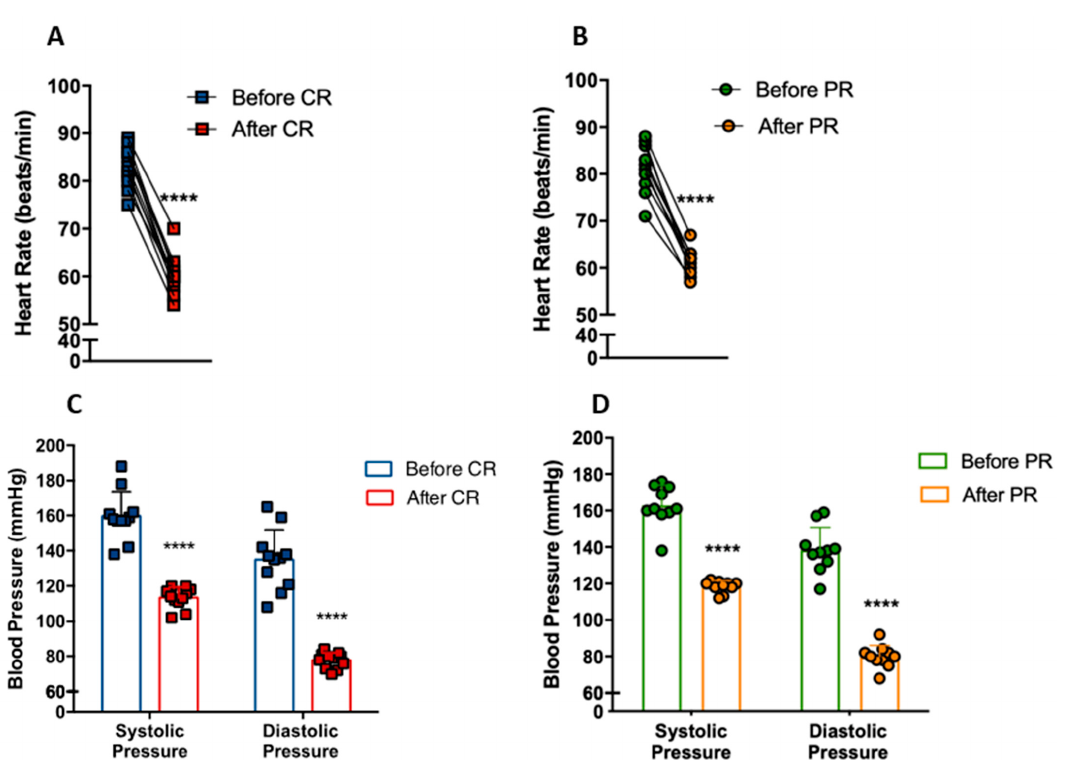
Figure 3. Reduction of cardiovascular disease risk factors after caloric restriction (CR) or protein restriction (PR). ( A ) Heart rate at rest before and after caloric restriction (**** p = < 0.0001). ( B ) Heart rate at rest before and after protein restriction (**** p = < 0.0001). ( C ) Blood pressure before and after caloric restriction (**** p = < 0.0001). ( D ) Blood pressure before and after protein restriction (**** p = < 0.0001). Data are presented in dot-plot format. Paired t -test was performed.